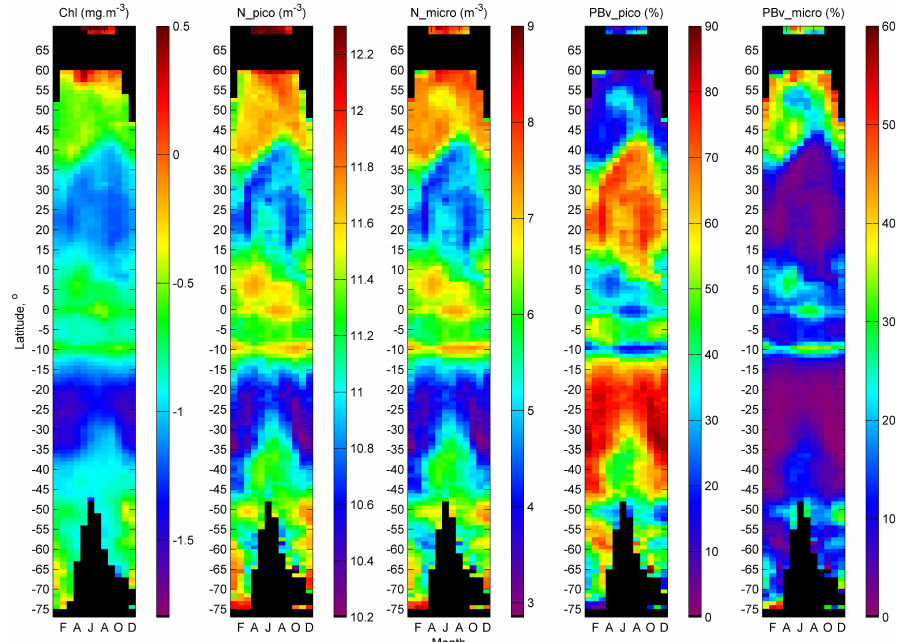
Fig. 10. Meridional-time transects along 140 ◦ W of SeaWiFS OC4v4 Chl (leftmost panel) and several relevant SeaWiFS PSD algorithm products from left to right, particle number concentration in the picoplankton (0.5 to 2µm) and microplankton (20–50µm) size ranges, and percent particle volume due to picoplankton and microplankton. The resolution is 1 degree by 1 month; values for each month were obtained by taking the spatial mean of a 4 × 4 pixel box. Color scales are in log10 space for the first three panels and linear for the last